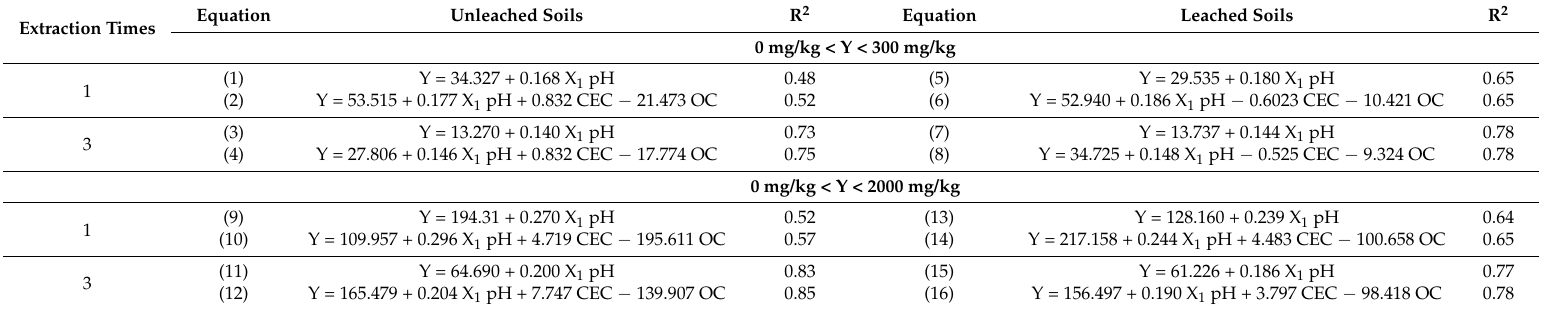
Table 4. Linear regressions between EDTA extractable Ni and total Ni added to soils as affected by soil